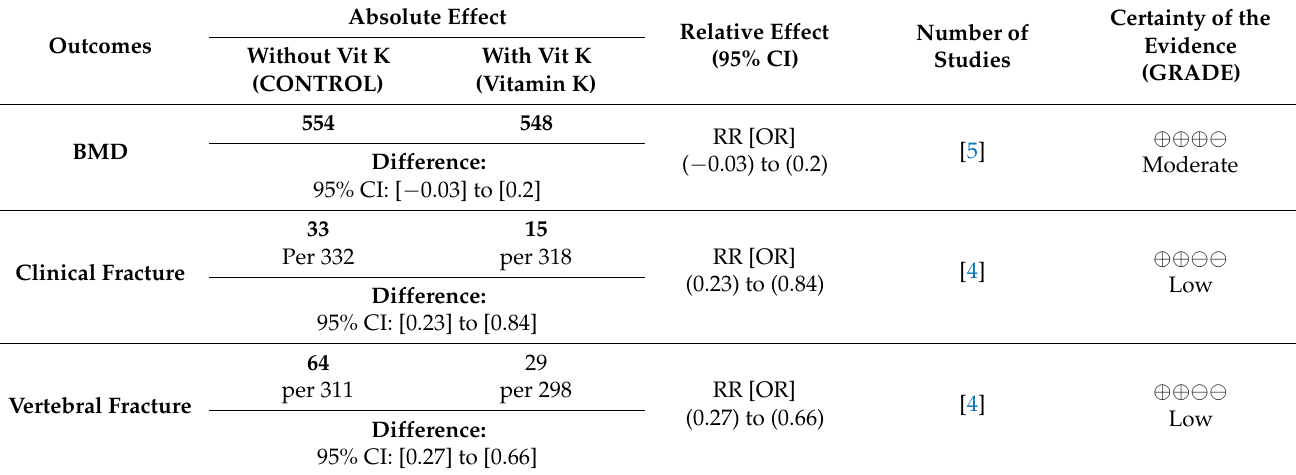
Table 3. Summary of findings: Effect of Vitamin K on bone mineral density and fracture risk in adults.